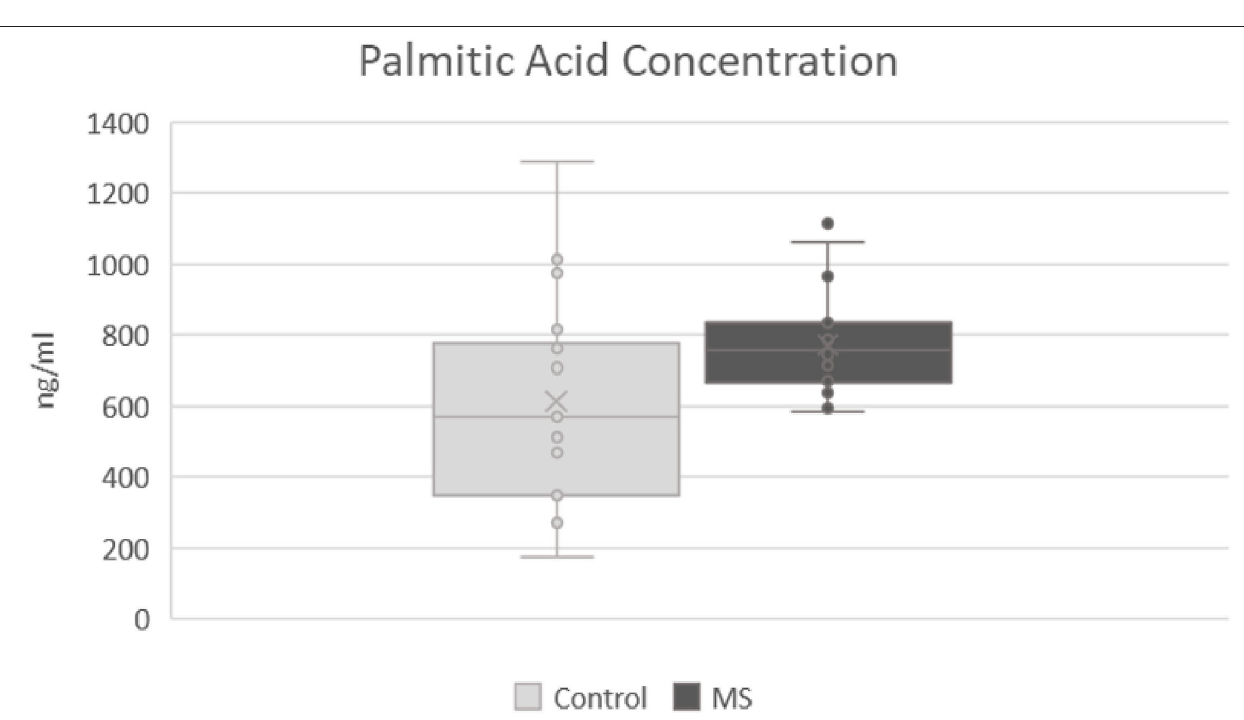
Frontiers in Neurology |